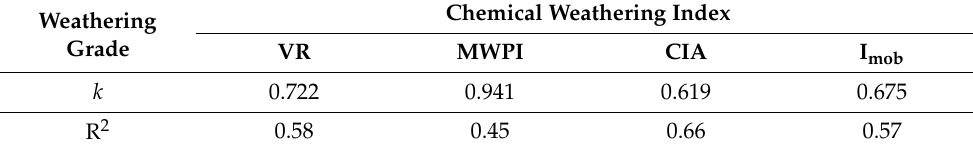
Table 5. Curve-fitting parameter.